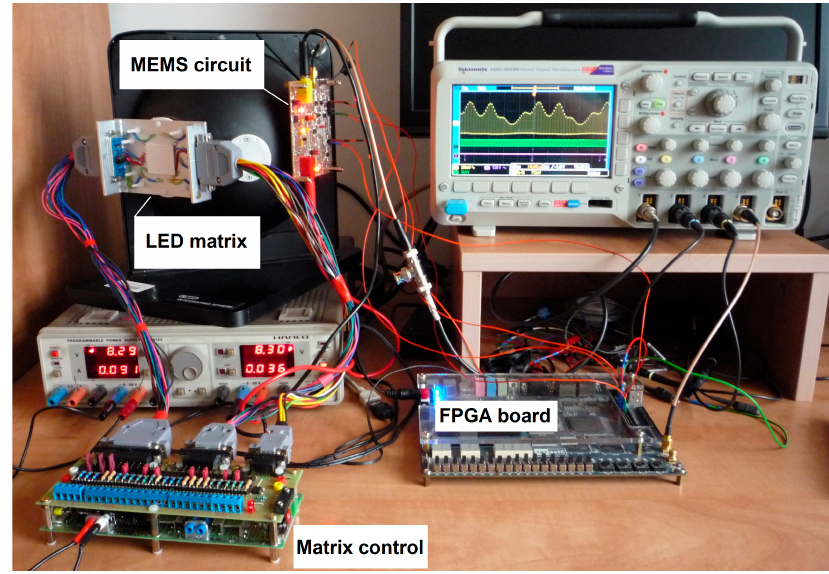
Figure 5. Measurement stand of prototype MEMS